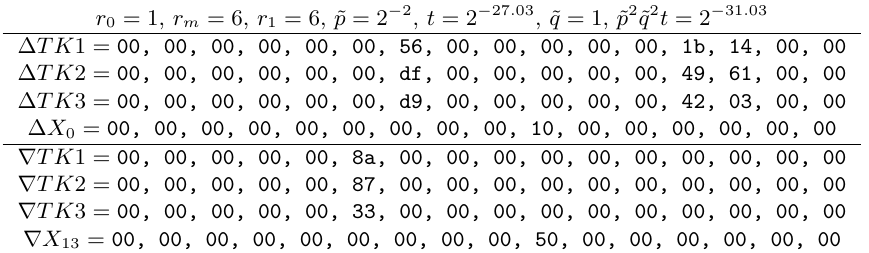
Table 25: The 13-round related-tweakey boomerang distinguisher for SKINNY-128-384